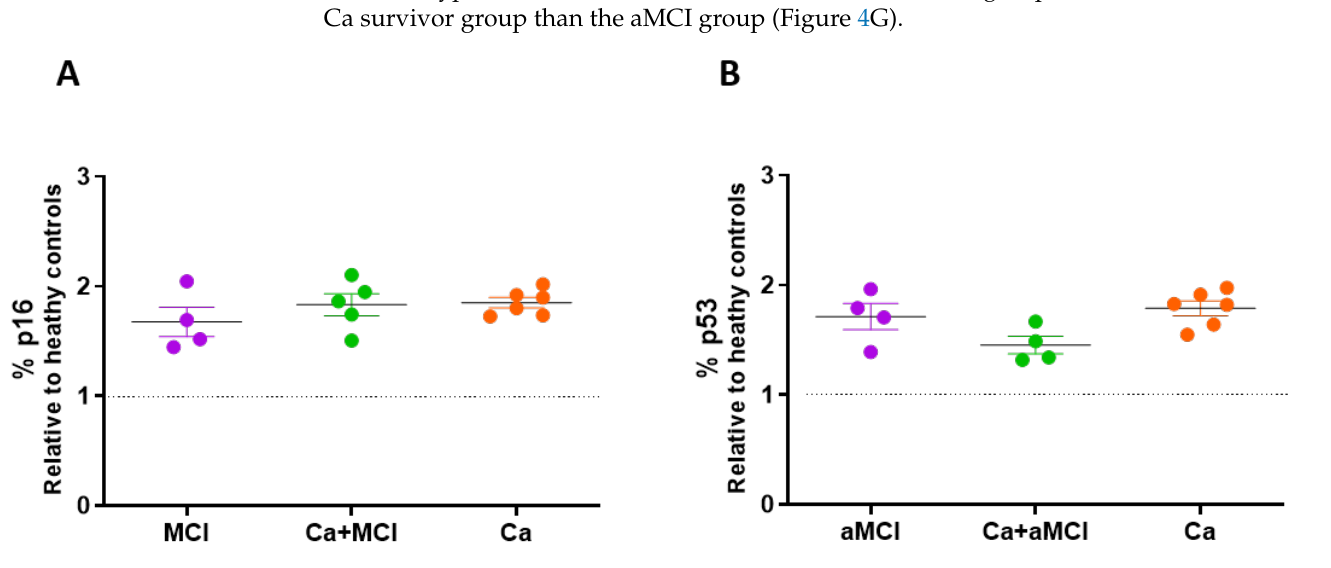
Figure 3. The expression of p16 and p53 was not significantly different in PBMCs of aMCI, Ca + aMCI and Ca survivors. Expressions of p16 ( A ) and p53 ( B ) were determined by flow cytometry in PBMCs from aMCI (n = 4), Ca + aMCI (n = 5) and Ca survivors (n = 6). The results are expressed relative to the mean value of healthy controls (dotted line, 40.2 ± 8.7% for p16; 39.0 ± 7.2% for p53, mean ± SE). Statistical analysis: Kruskal–Wallis with Dunn’s post hoc correction.